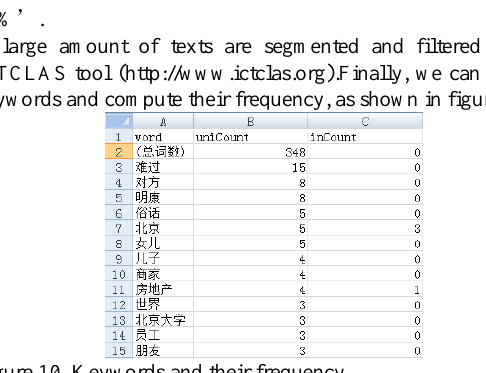
Figure 10. Keywords and their frequency